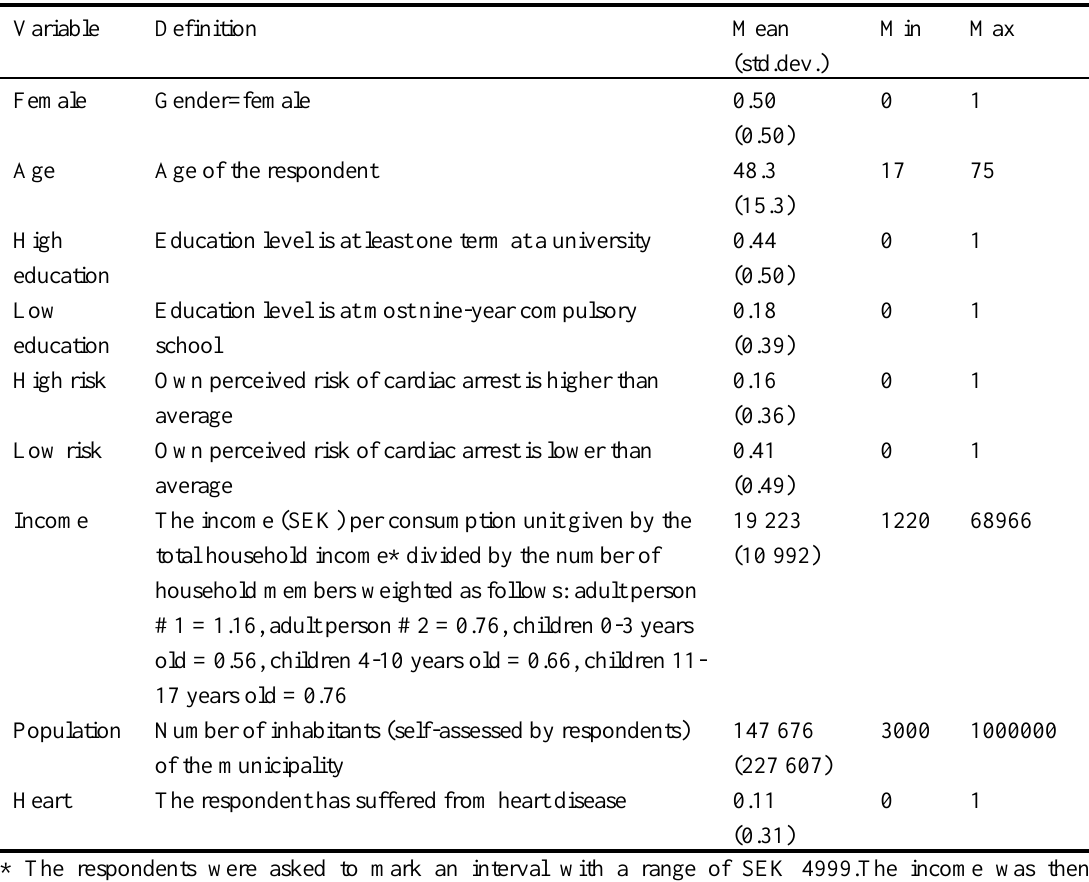
Table A2: Sample statistics